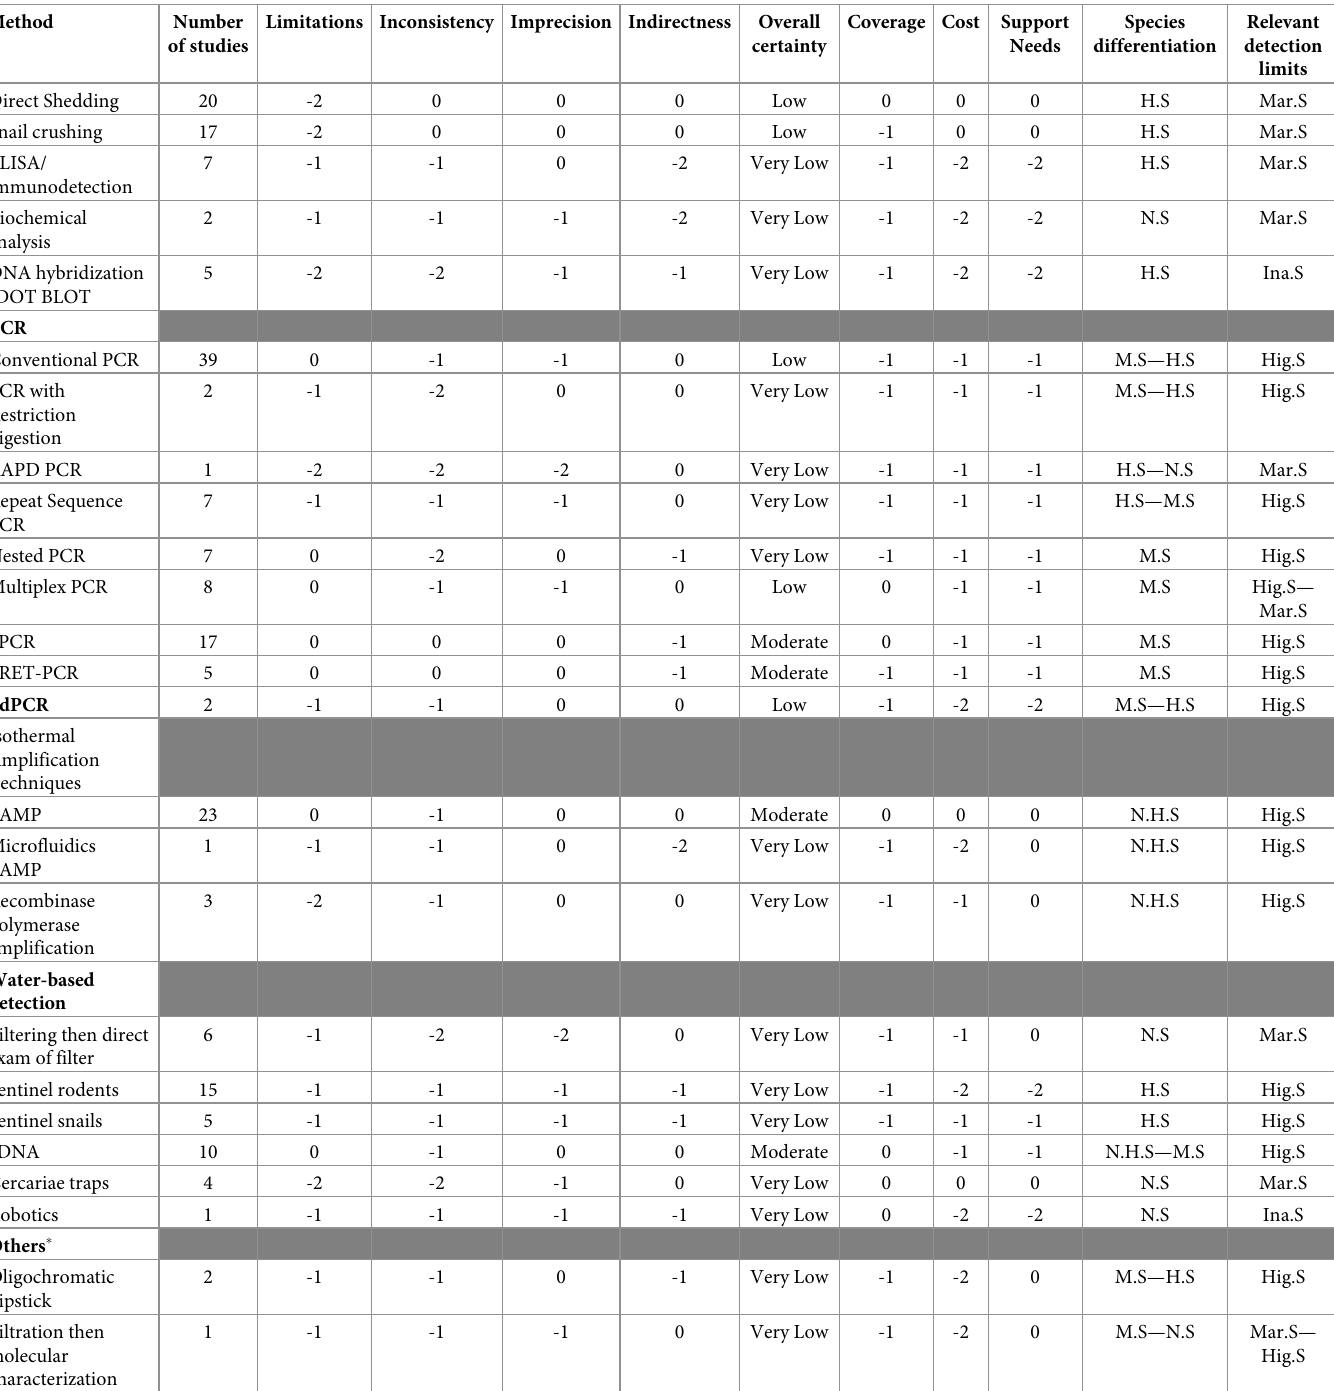
Table 2. Grade Summary Table. We used the numbers 0, -1, -2 to score every method, with 0 being adequate, -1, serious concern, -2 very serious concern. It is worth not- ing that publication bias is not part of this table, as we did not have any reason to suspect it has occurred with any of the methods. We defined species differentiation ability of each method as N.S = Nonspecific, H.S = Heterospecific, N.H.S = Narrowly Heterospecific, M.S = Monospecific. And relevant detection limits as Hig.S, High sensitiv- ity , Mar.S = Marginal sensitivity , Ina.S = Inadequate